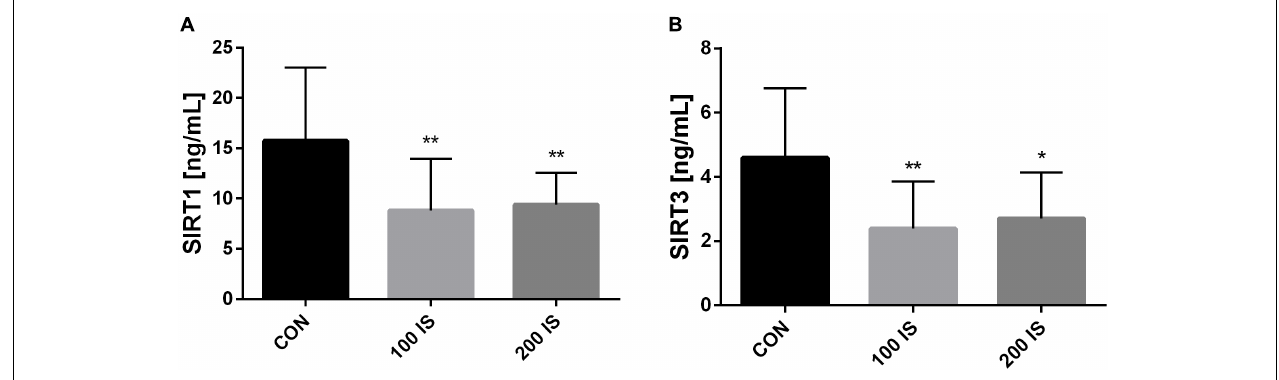
FIGURE 5 | The effect of IS on SIRT1 (A) and SIRT3 (B) levels in aortas. Data are presented as the mean ± SD. CON, control group; 100 IS, group receiving IS in the dose of 100 mg/kg b.w./day; 200 IS, group receiving IS in the dose of 200 mg/kg b.w./day; IS, indoxyl sulfate; SIRT1, sirtuin 1; SIRT3, sirtuin 3; ∗ p < 0.05 compared to control; ∗∗ p < 0.01 compared to control. TABLE 4 | Effect of IS on blood morphology parameters. CON 100 IS 200 IS